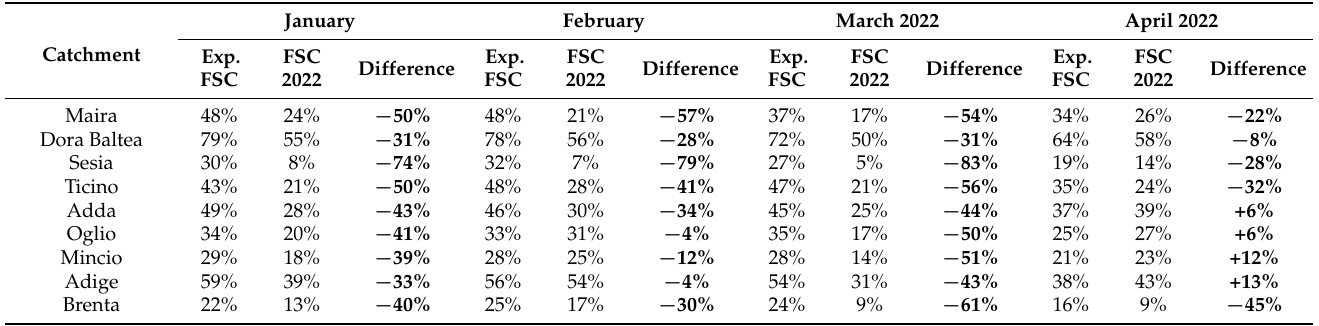
Table 2. Expected fractional snow cover (FSC, median 1985–2021), observed FSC (2022), and difference between observation and expected values (bold) in each